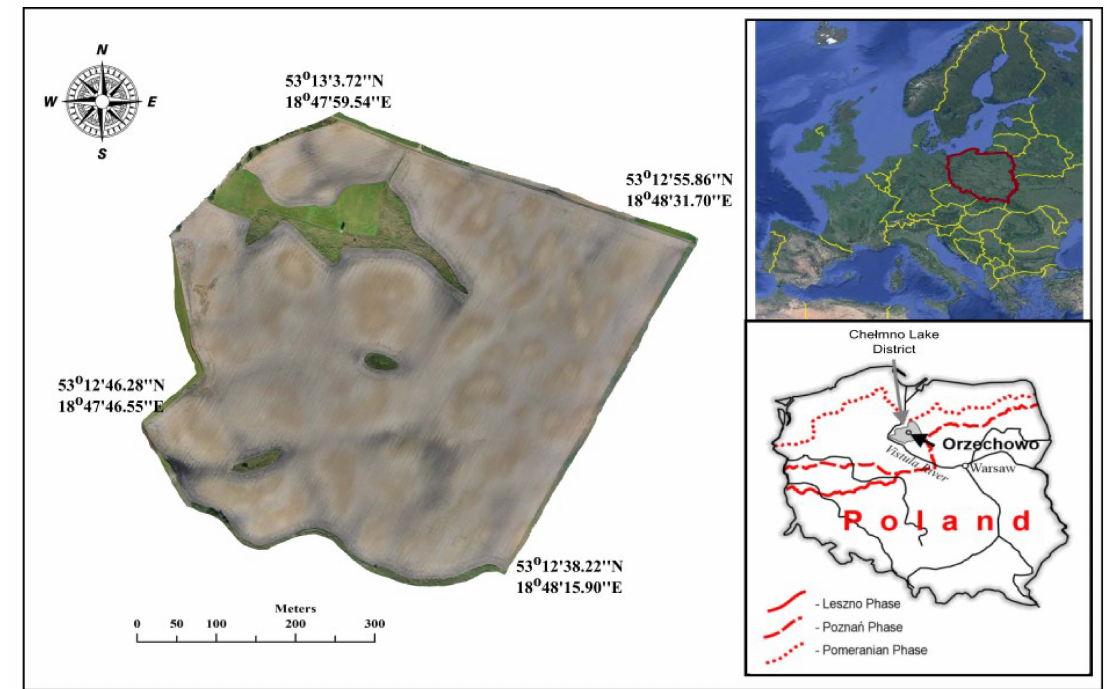
Figure 2. Location of the experimental plot in Orzechowo (Northern